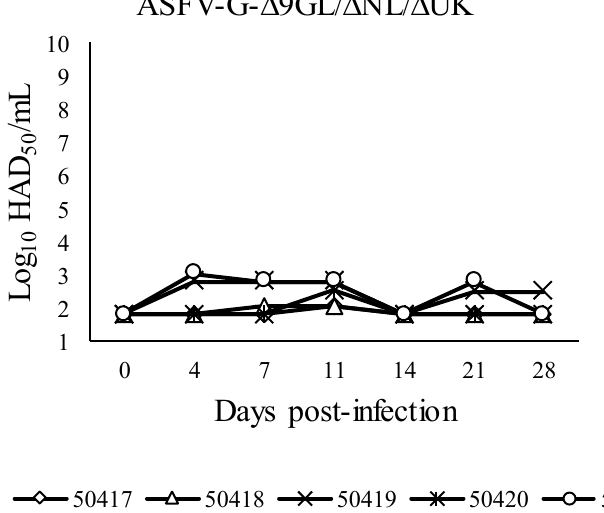
Figure 6. Virus titers in blood samples obtained from pigs infected with 10 4 HAD 50 of ASFV-G- ∆ 9GL / ∆ NL / ∆ UK. Values are expressed as log 10 HAD 50 / mL. Sensitivity of virus detection: ≥ 10 1.8 HAD 50 /mL.